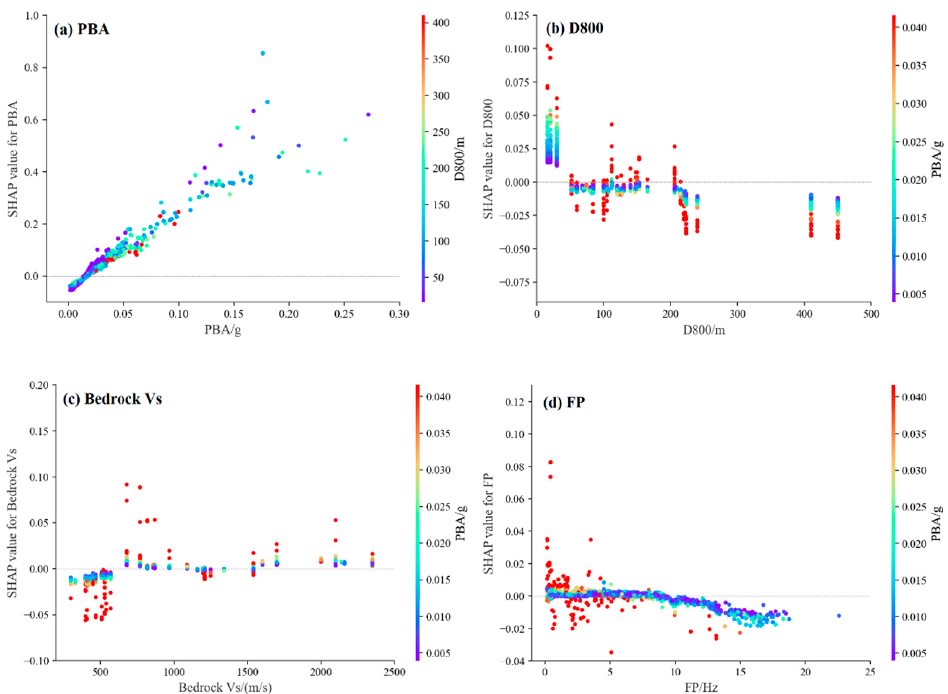
Figure 15. SHAP dependency plots for XGBoost.